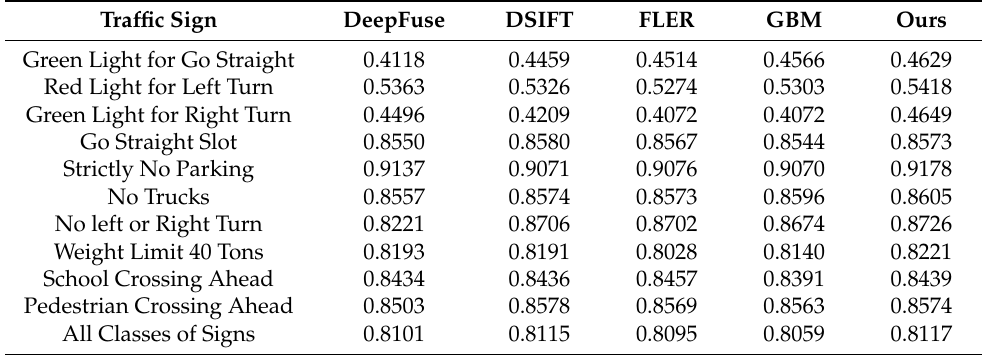
Table 4. Comparison of classification accuracy of other four methods and